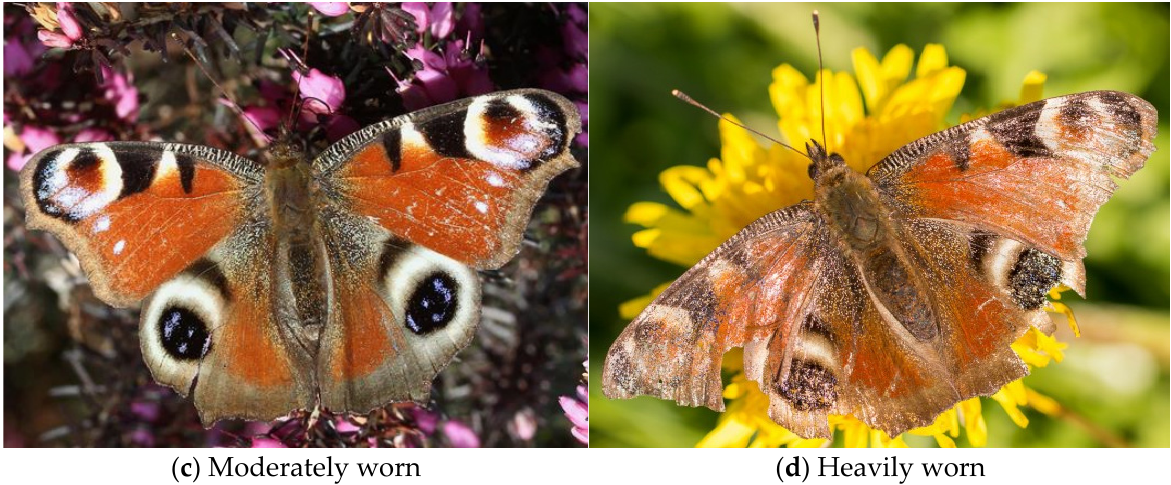
Figure 1. Examples of classification of the condition of wing wear in peacock butterflies.